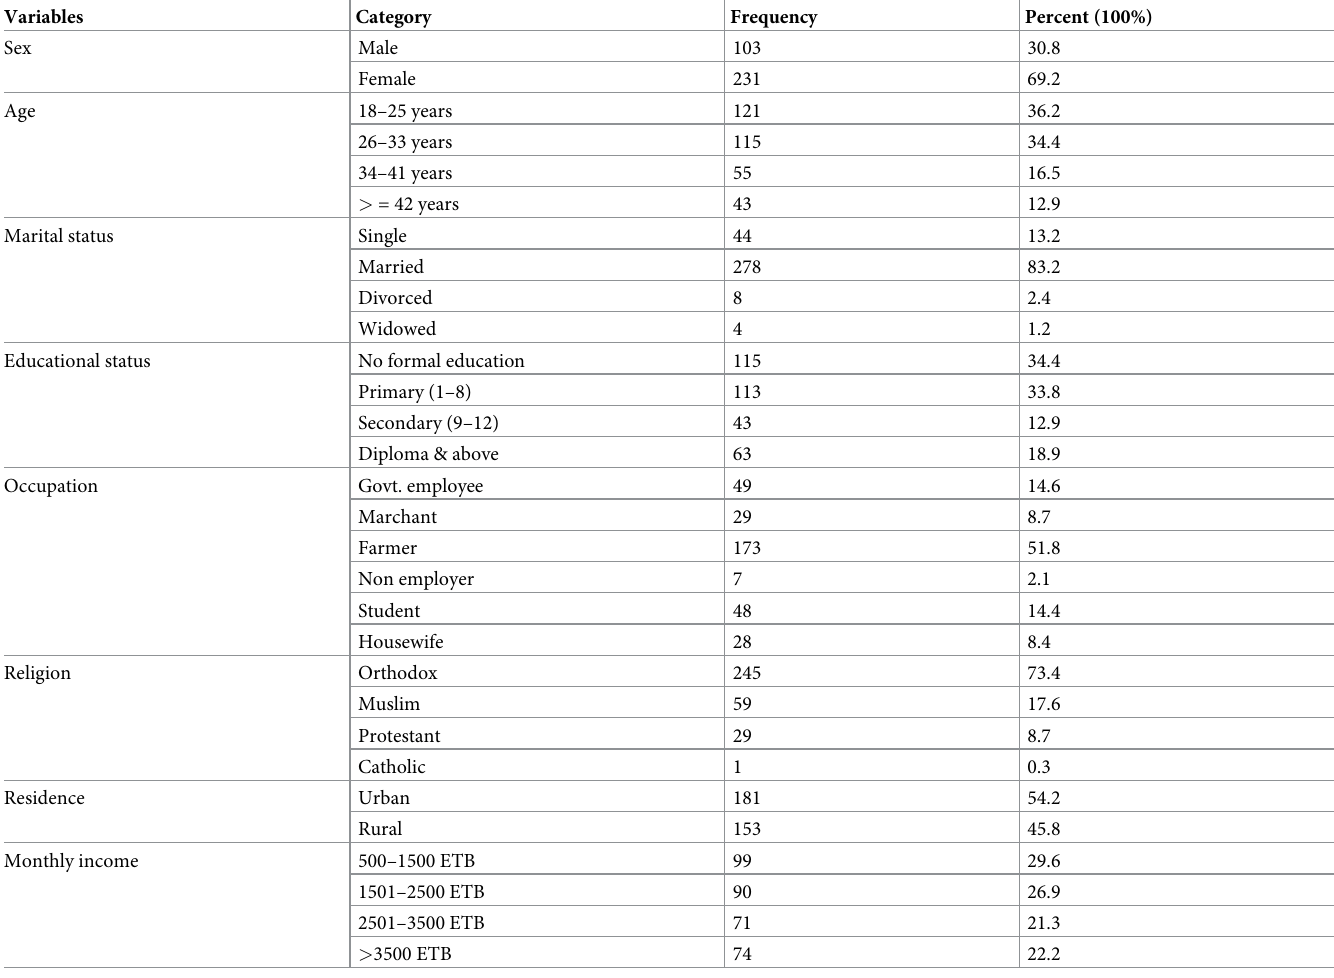
Table 1. Sociodemographic characteristics of the respondents at Pawie General Hospital Benishangul Gumuze Region, West Ethiopia, 2020 (n =